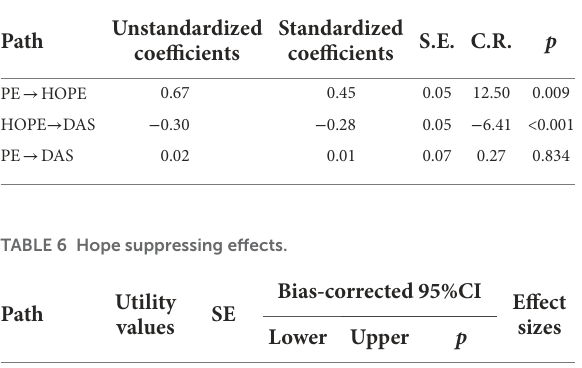
TABLE 5 Perseverance of effort path analysis.